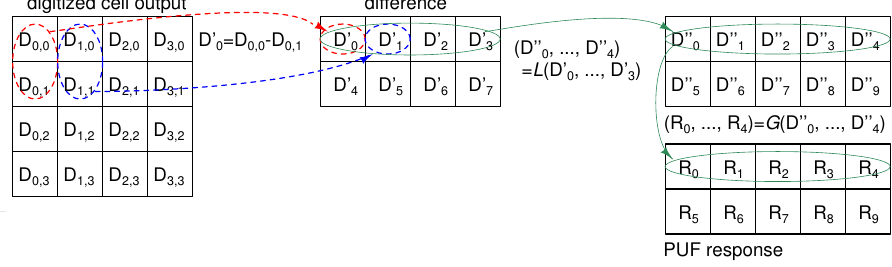
Figure 5. Operation diagram of L.G.